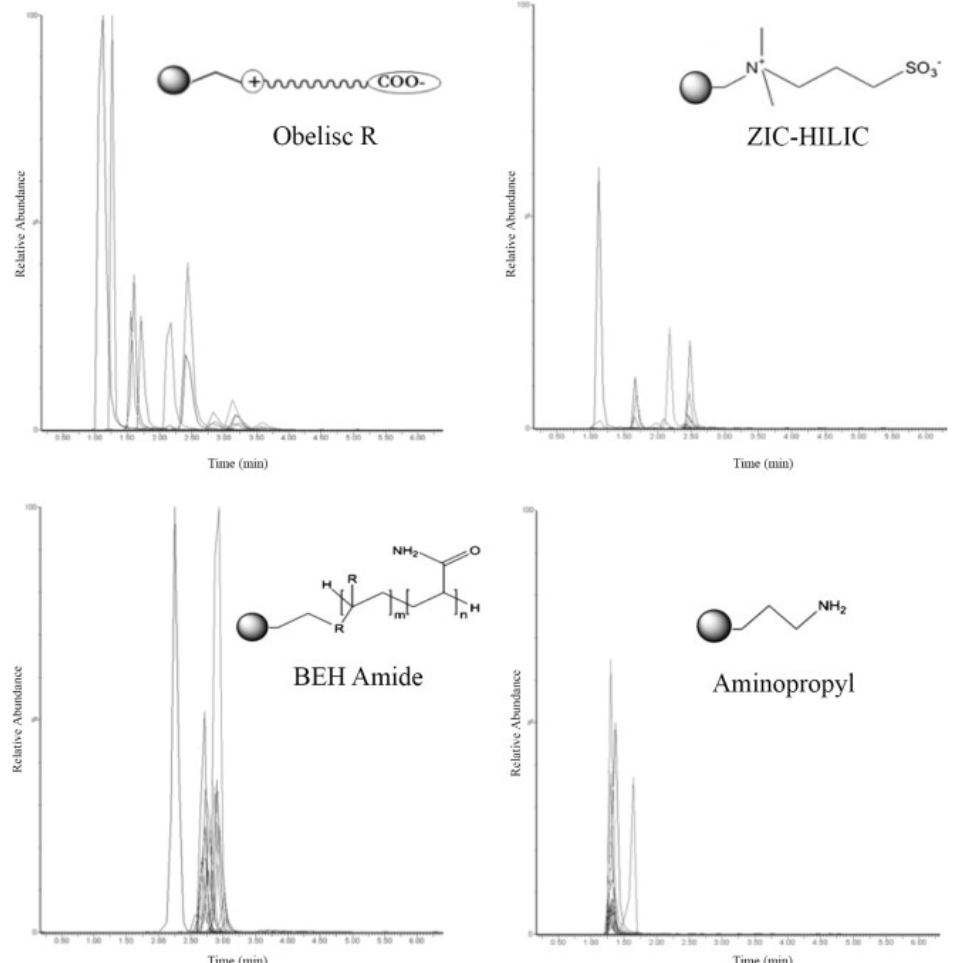
Figure 2. Fourteen aminoglycosides standard solution separated on the four selected stationary phases with optimised conditions. Reproduced with permission [47].